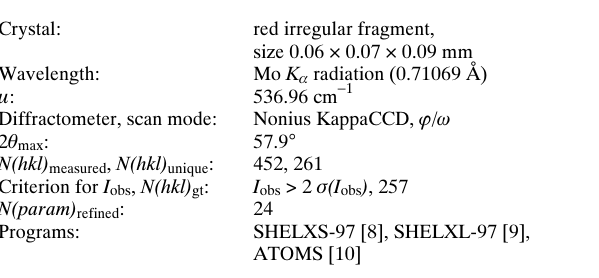
Table 1. Data collection and